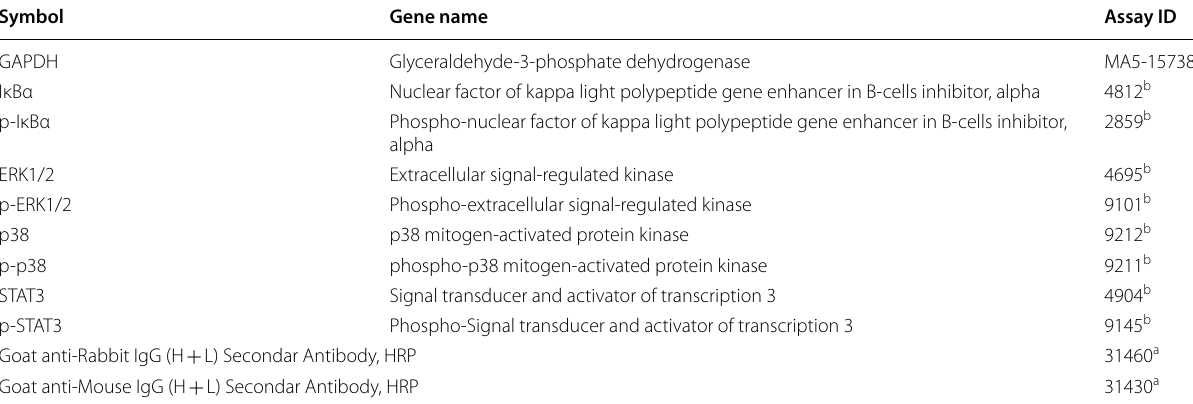
Table 2 List of protein name and antibody used in western blot analysis